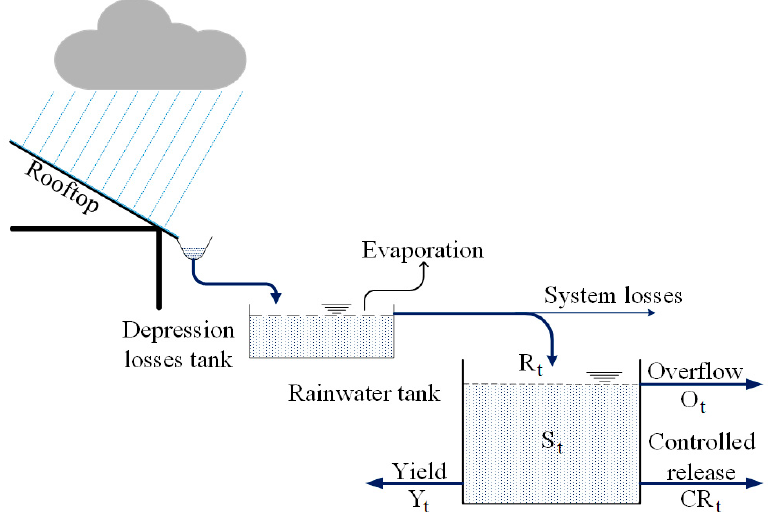
Figure 1. Modeling framework of a rainwater harvesting system. The conceptual depression losses tank needs to overflow to initiate inflows to the main rainwater tank. The rainwater tank is gaining water when R t > 0, and lose water due to overflows, yield (demands) or controlled release (if the latter is